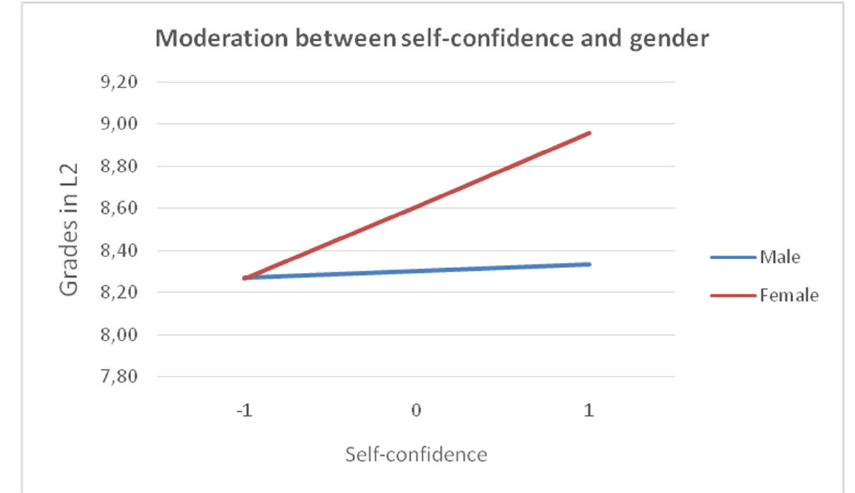
Chart 2. Moderation between self-confidence and gender based on the grade in L2 Residing in the country of native speaker as